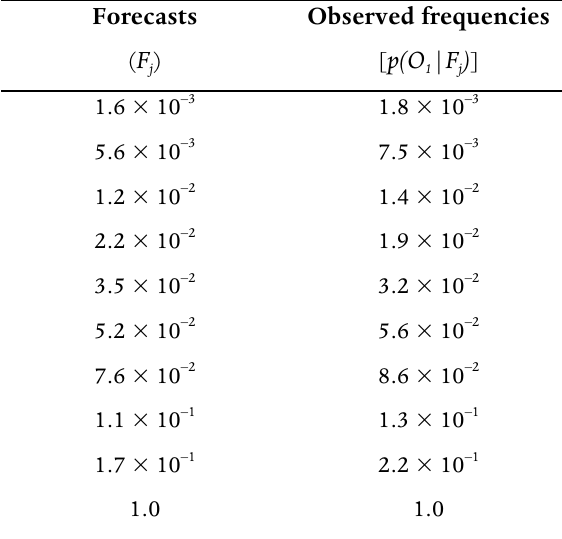
Table 2. Values for the cumulative reliability diagram of the spatial distri- bution of earthquakes predicted by the ETAS model relative to the testing =2.5; June 1, 2009, to September 1, 2009; 179 INGV bulletin. ( M c